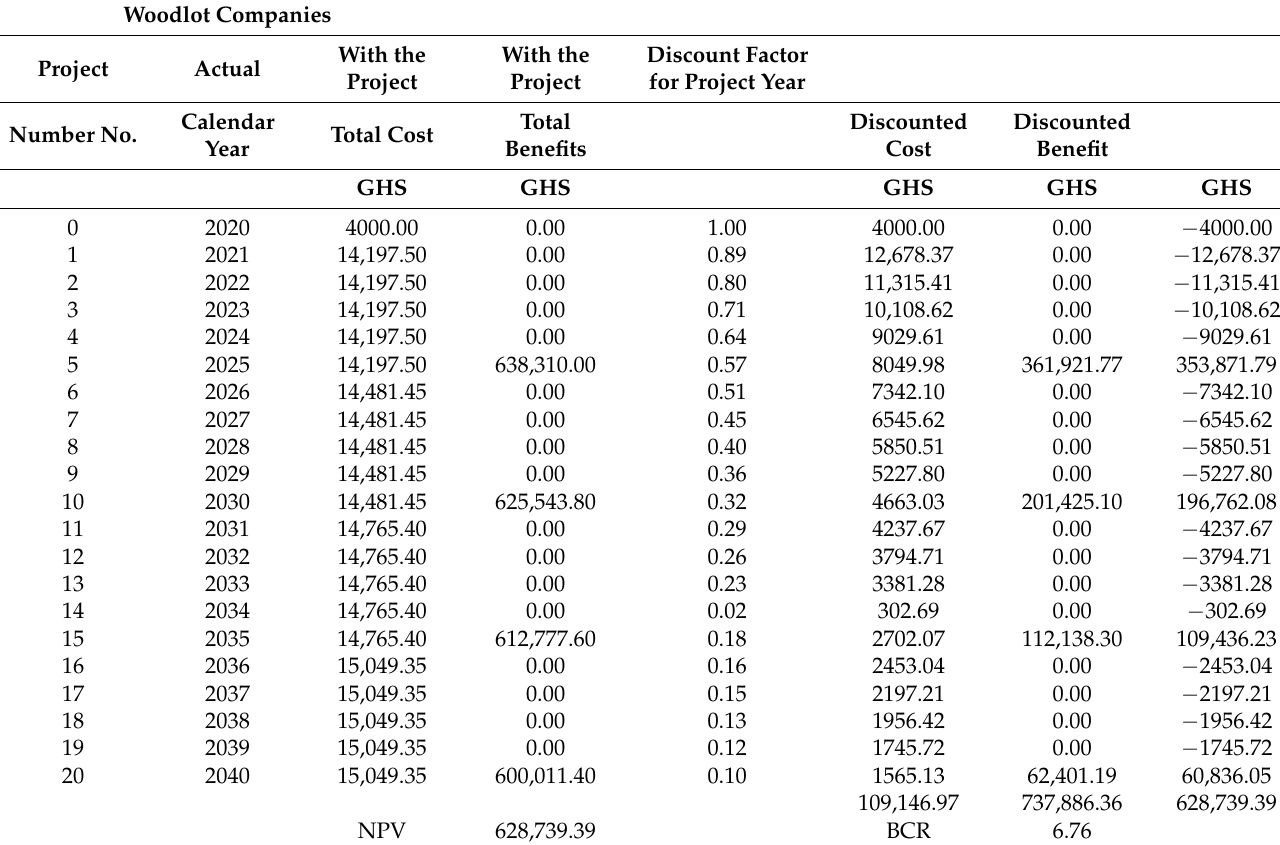
Table A8. Profitability of woodlot farmers (farmers in contractual relationship with other forestry companies).